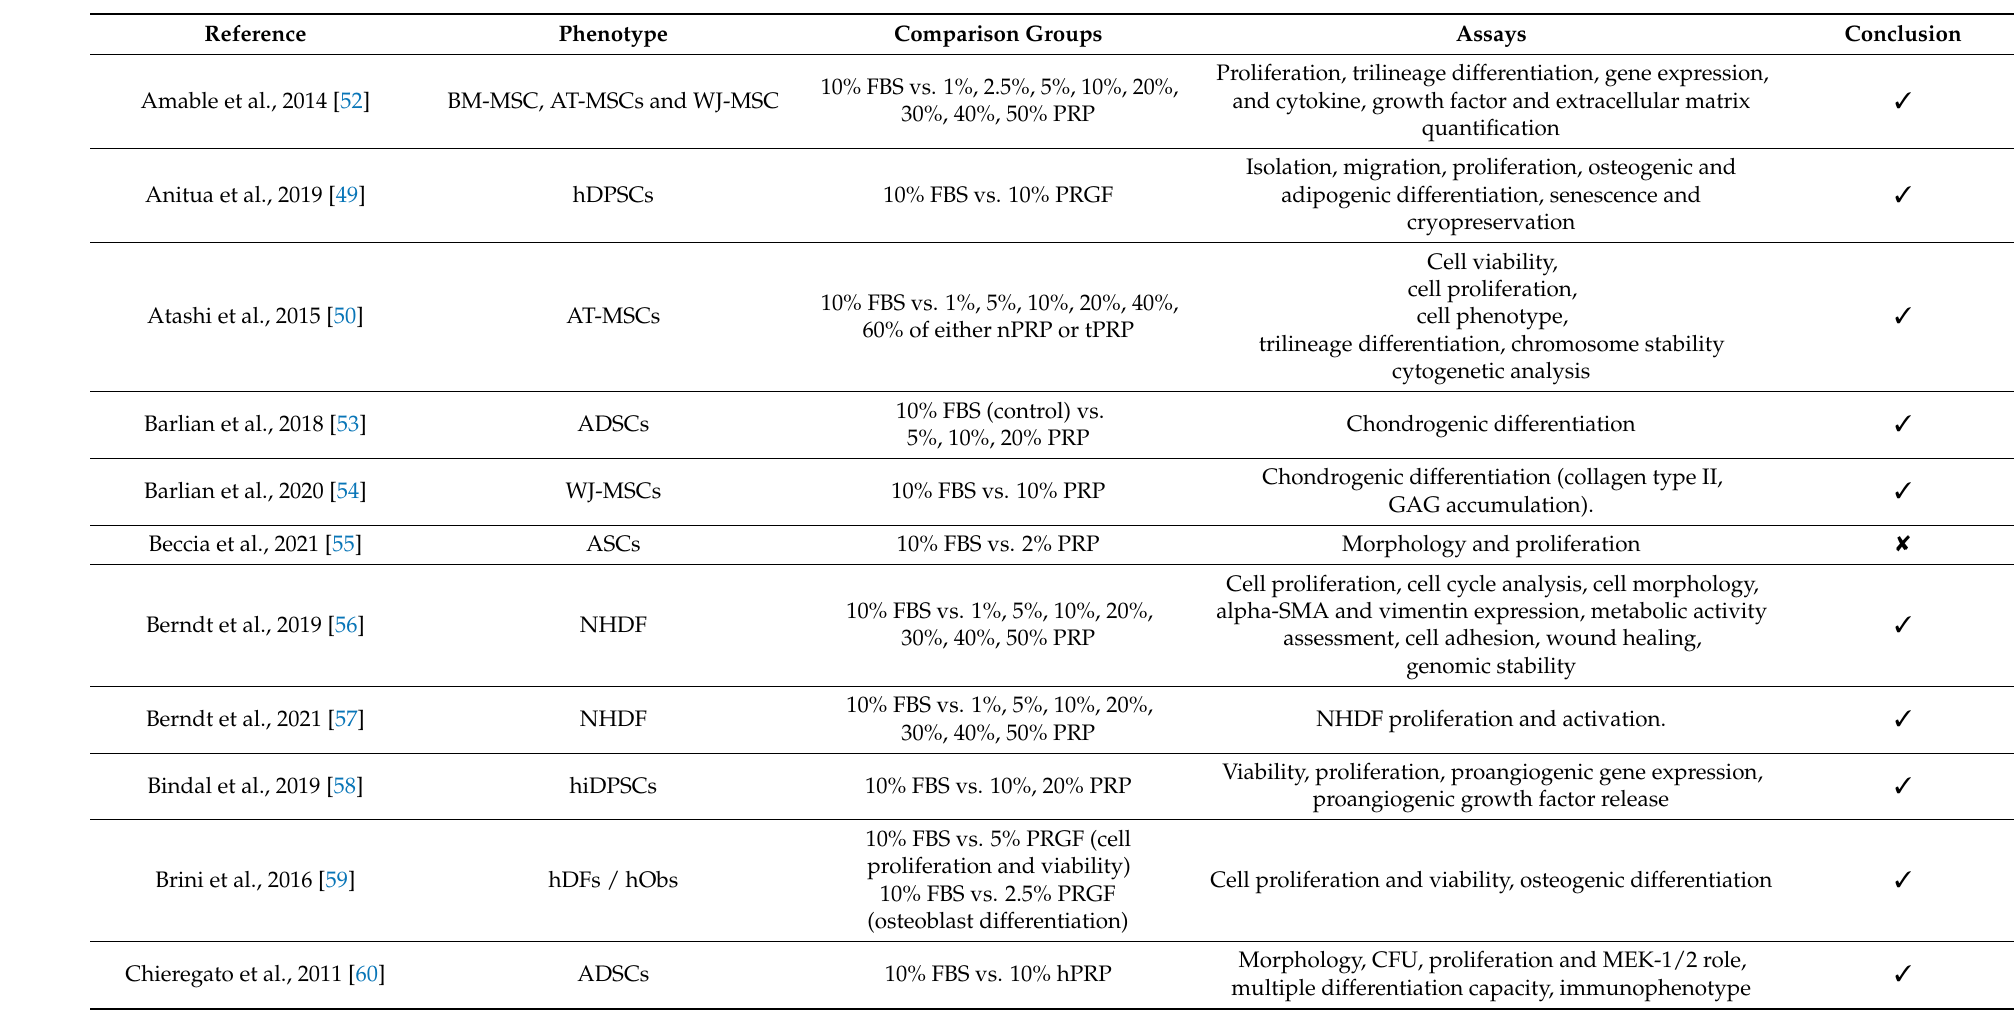
Table 1. Detailed information of the studies included in this